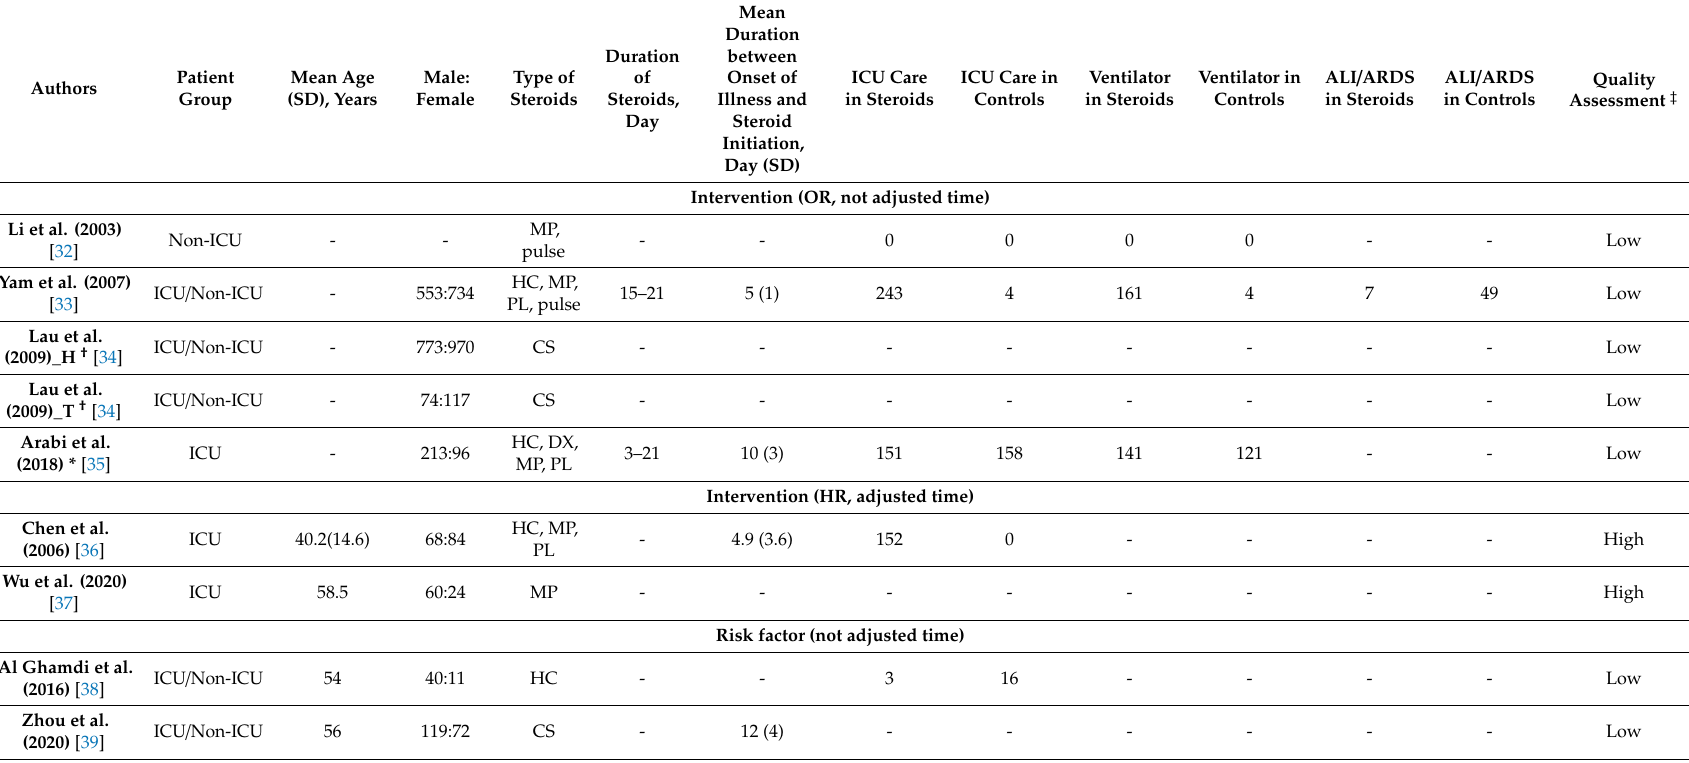
Table 2. Detailed distribution of patient of the studies included in the